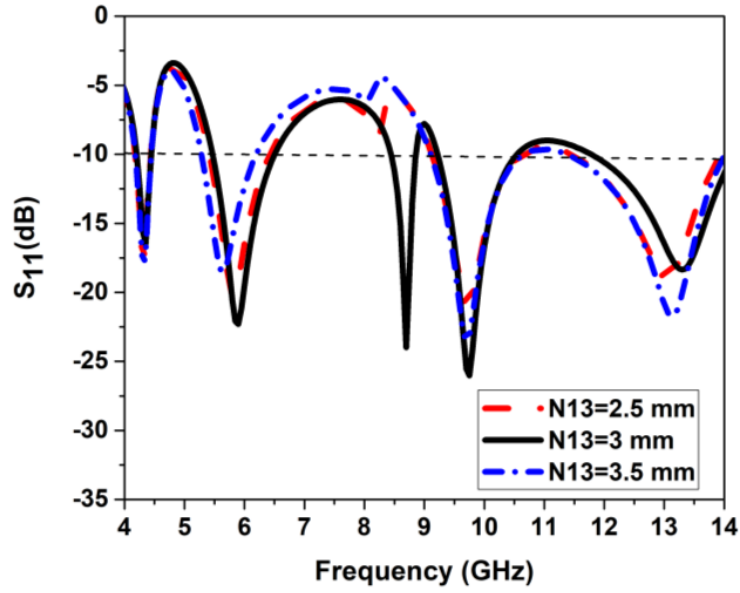
Figure 21. S 11 for variation of length ‘N13’.